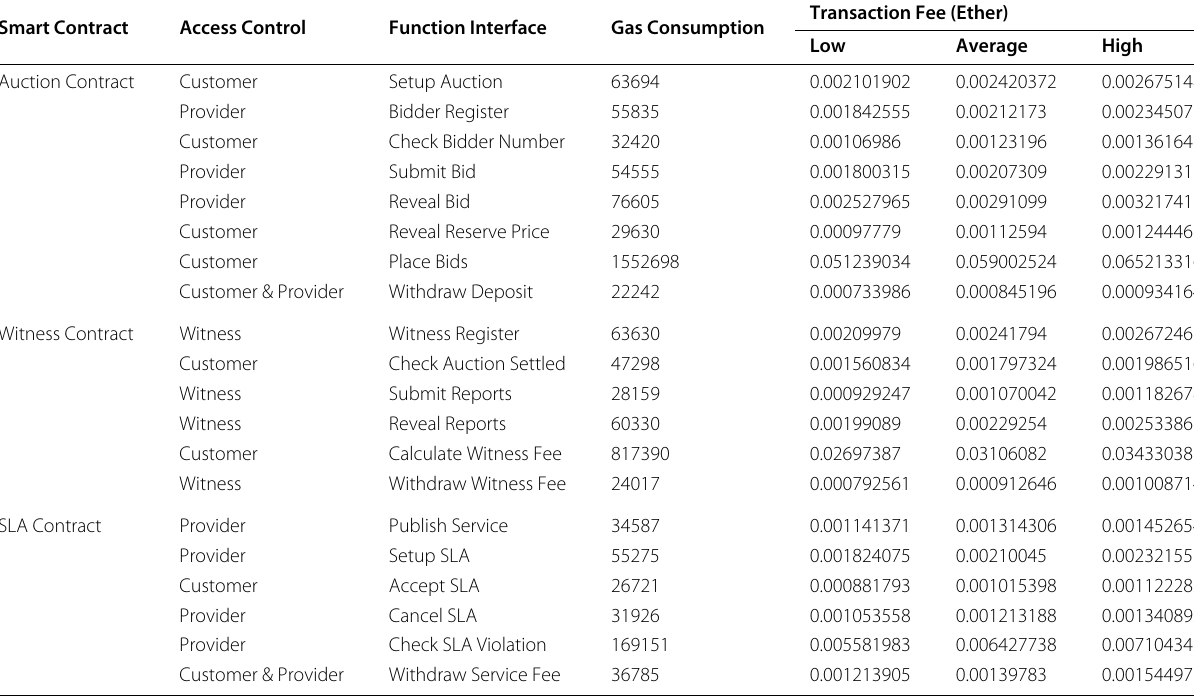
Table 2 The gas consumption and access control mechanisms of function interfaces in AWESOME smart contracts Smart Contract